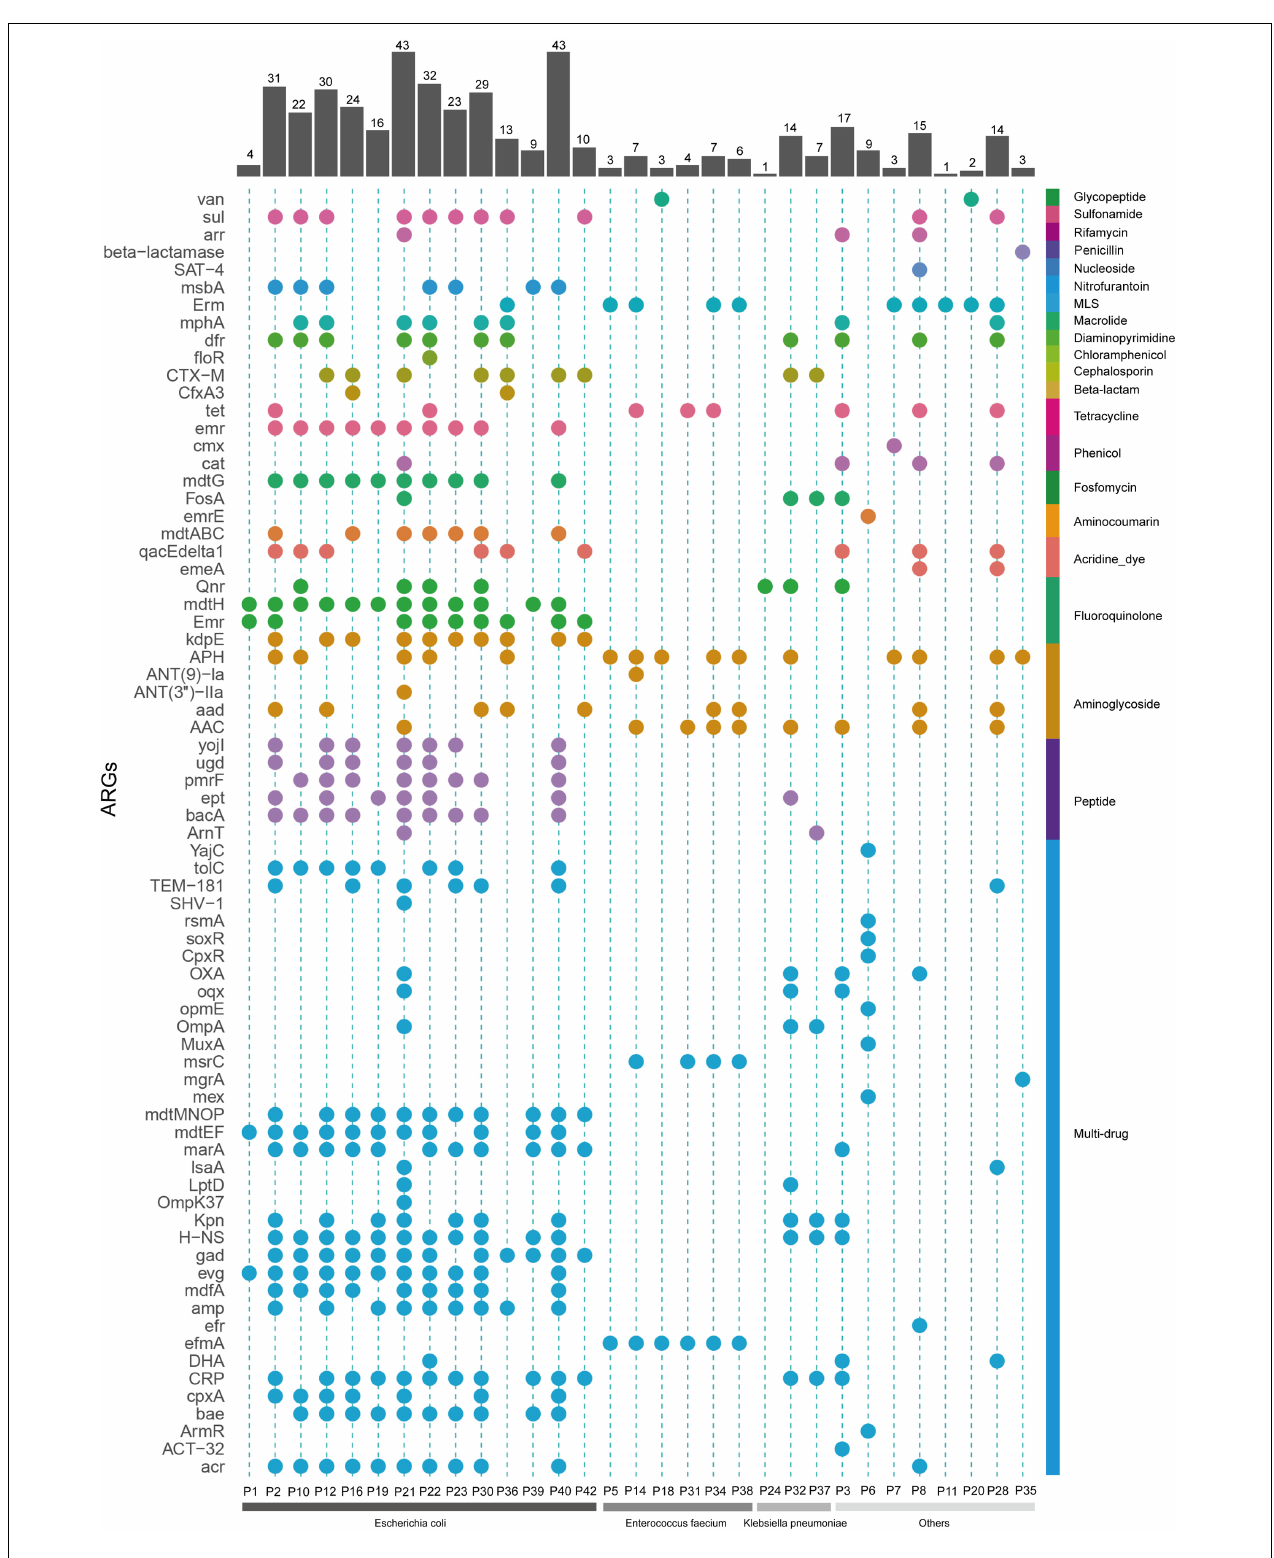
FIGURE 5 | Resistance genes profile of all the mNPS-based positive samples. Colors are to aid visual interpretation. Heatmap strip at the right with different colors represent different types of antimicrobial class. Heatmap strip at the bottom represents different pathogen species. Bar chart indicates the number of ARGs per